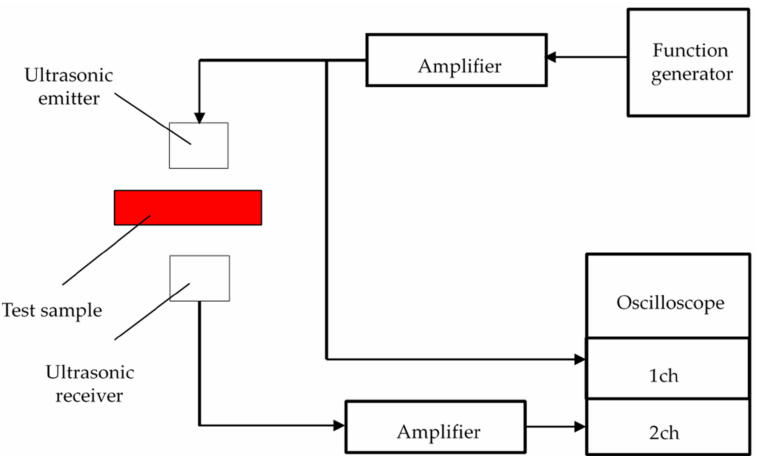
Figure 3. Configuration diagram of the tortuosity